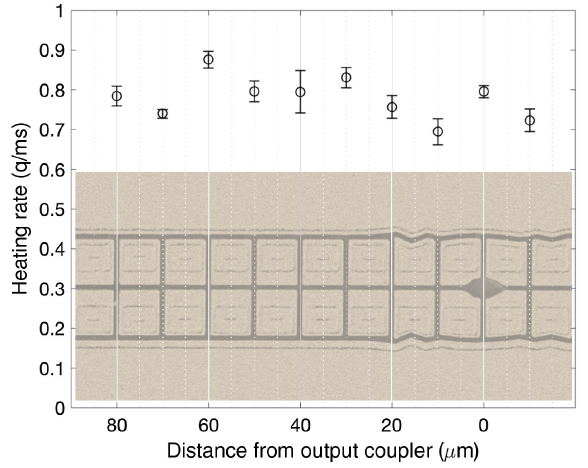
FIG. 3. Heating rate as a function of position overlayed on the trap region, where the output coupler for the waveguide is at 0 μ m, the loading hole is at 80 μ m, and the maximum overlap between the ion and the waveguide output light is at 70 μ m. No measurable change in heating rate is observed as the ion is shuttled from the loading hole to the output grating where it is closest to the exposed dielectric